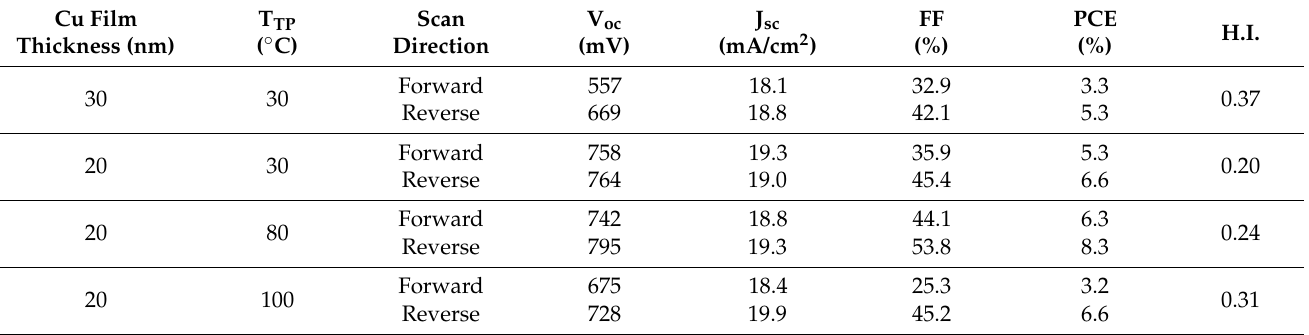
Table 1. Device parameters for CuI HTL-based devices fabricated with different thicknesses of copper films (t Cu ) and transfer-printing temperatures (T TP